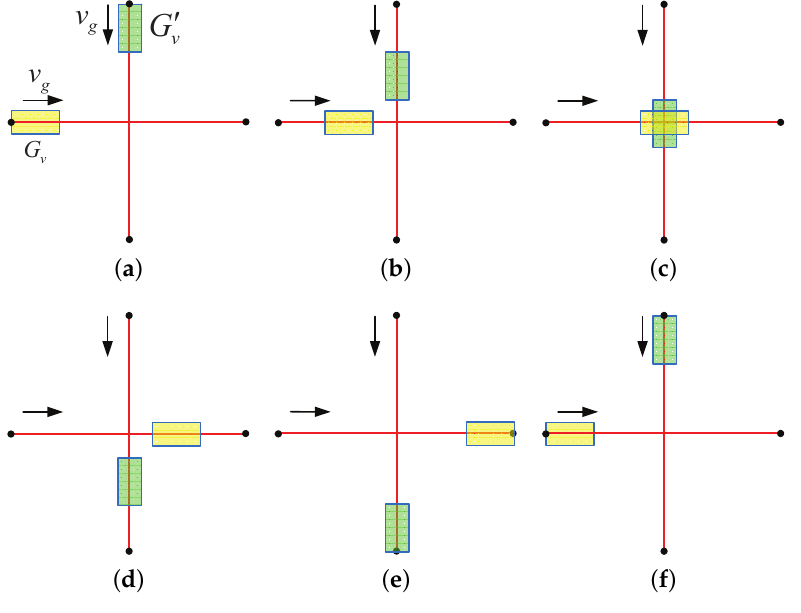
t c + ∆ t , ( c ) t = t 0 + 2 5